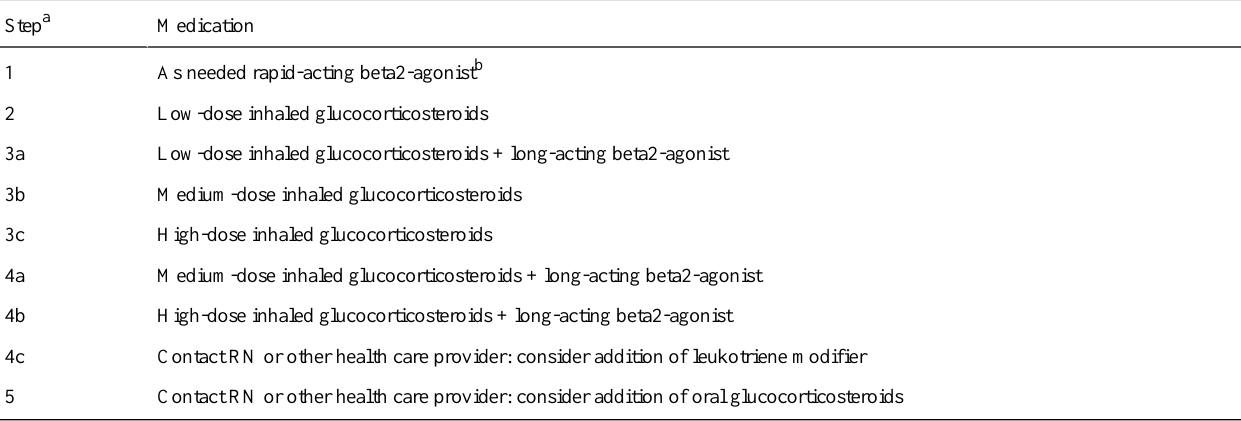
Table 1. Medication treatment steps. MedicationStep